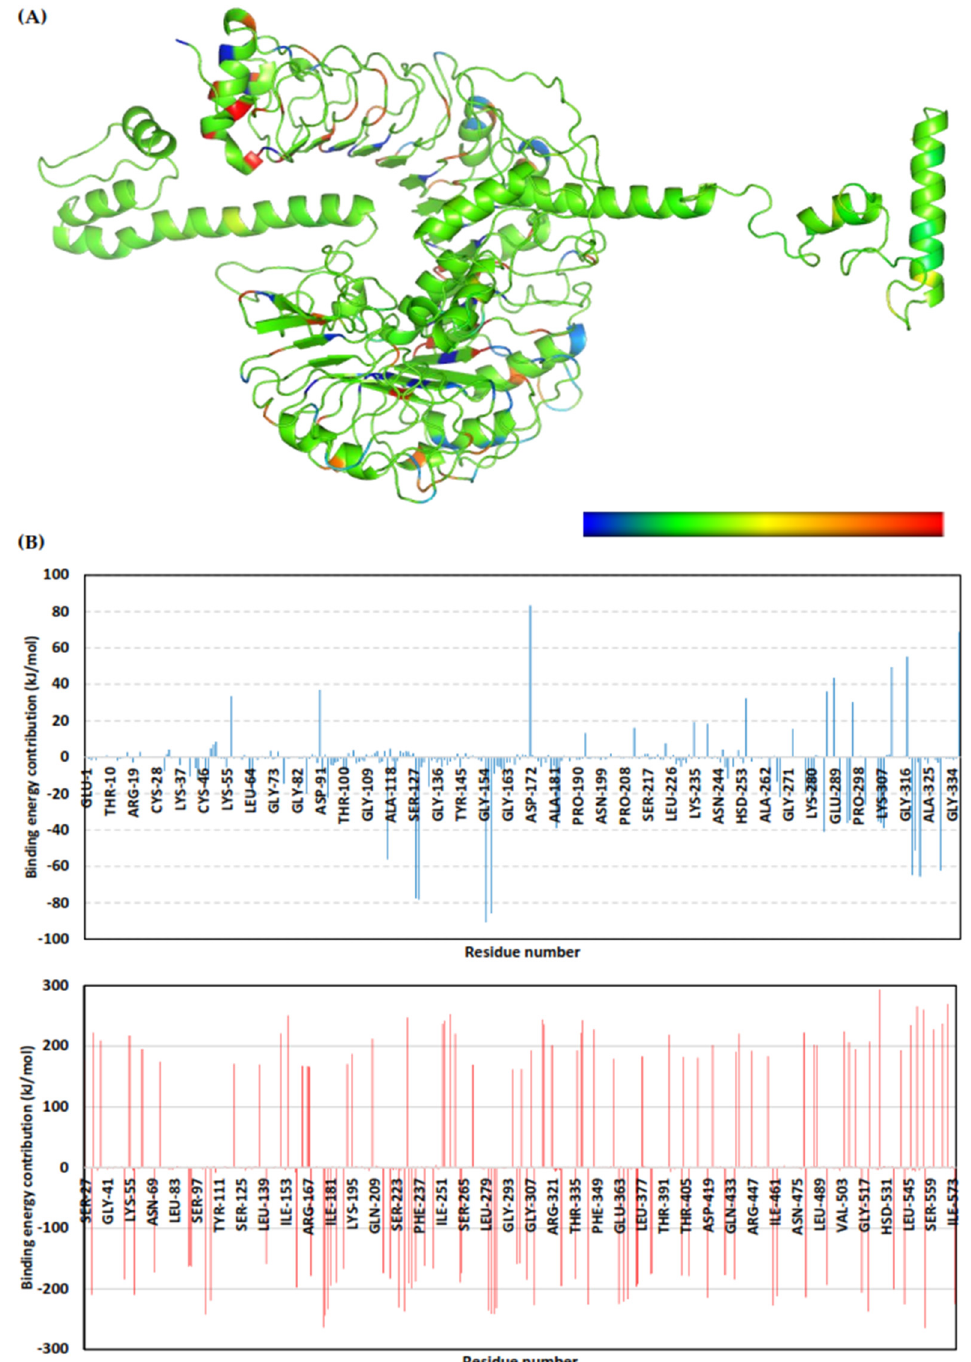
Figure 11. Binding-free energy/residue decomposition illustrating the protein residue contribution at ligand–protein complex ∆ G Total binding calculation. ( A ) Cartoon 3D representation for regions of the vaccine/TLR-2 complex favoring binding chemistry. Protein regions are colored in spectrum from dark blue (highly favored with high attractive forces as negative ∆ G kJ/mol values) down to dark red (most unfavored with high repulsive forces as positive ∆ G kJ/mol values); ( B ) Residue-wise free-binding energy contribution for vaccine (upper panel) and TLR-2 (lower panel) in terms of residues’ sequence